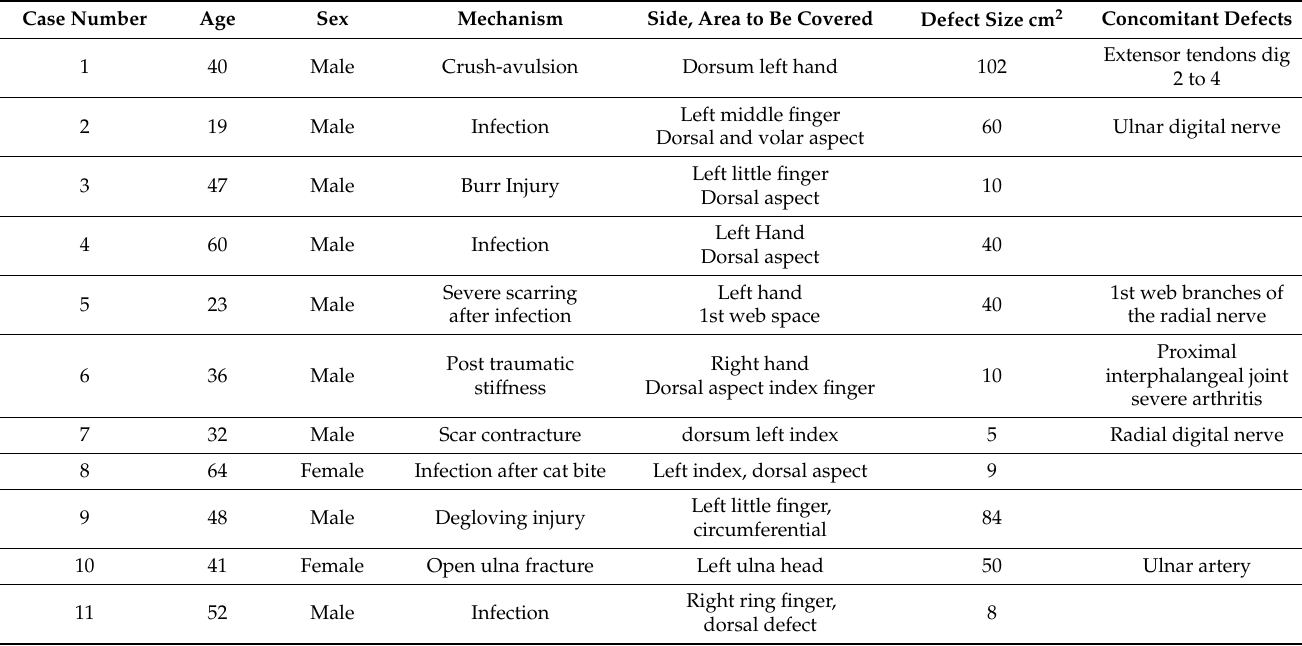
Table 1. Population of our series, with age, mechanism of the soft tissue defect, size of the defect, and concomitant important structures